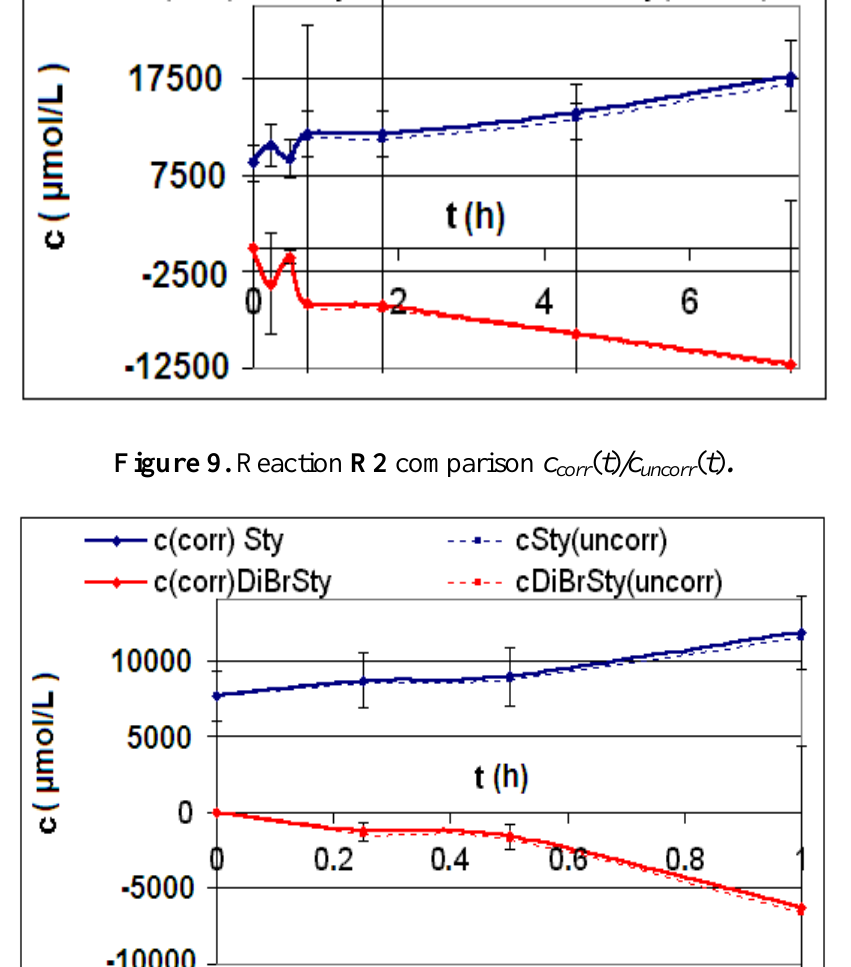
Figure 8. Reaction R1 comparison c